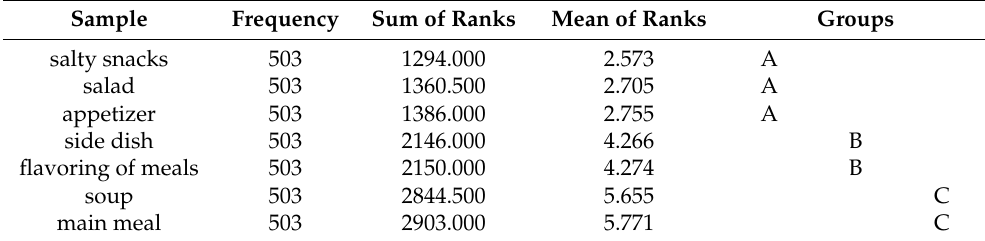
Table 5. Differences in the evaluation of preferred mushrooms meals in the “regular consumers” segment.